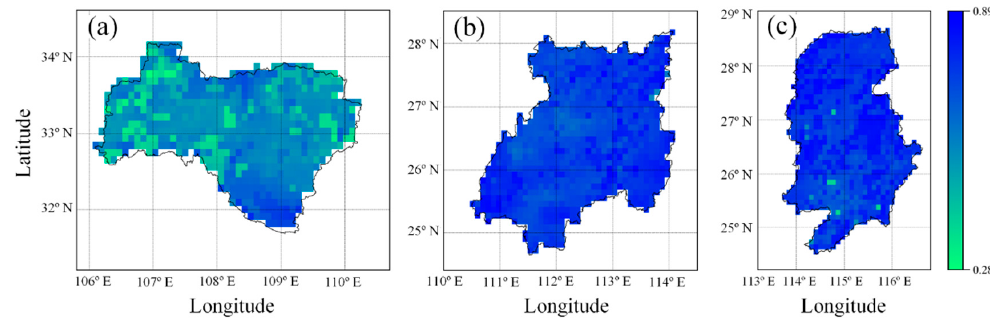
Figure 2. Temporal average values of SMAP root-zone soil wetness (dimensionless) over ( a ) the Hanjiang River catchment, ( b ) the Xiangjiang River catchment, and ( c ) the Ganjiang River catchment.